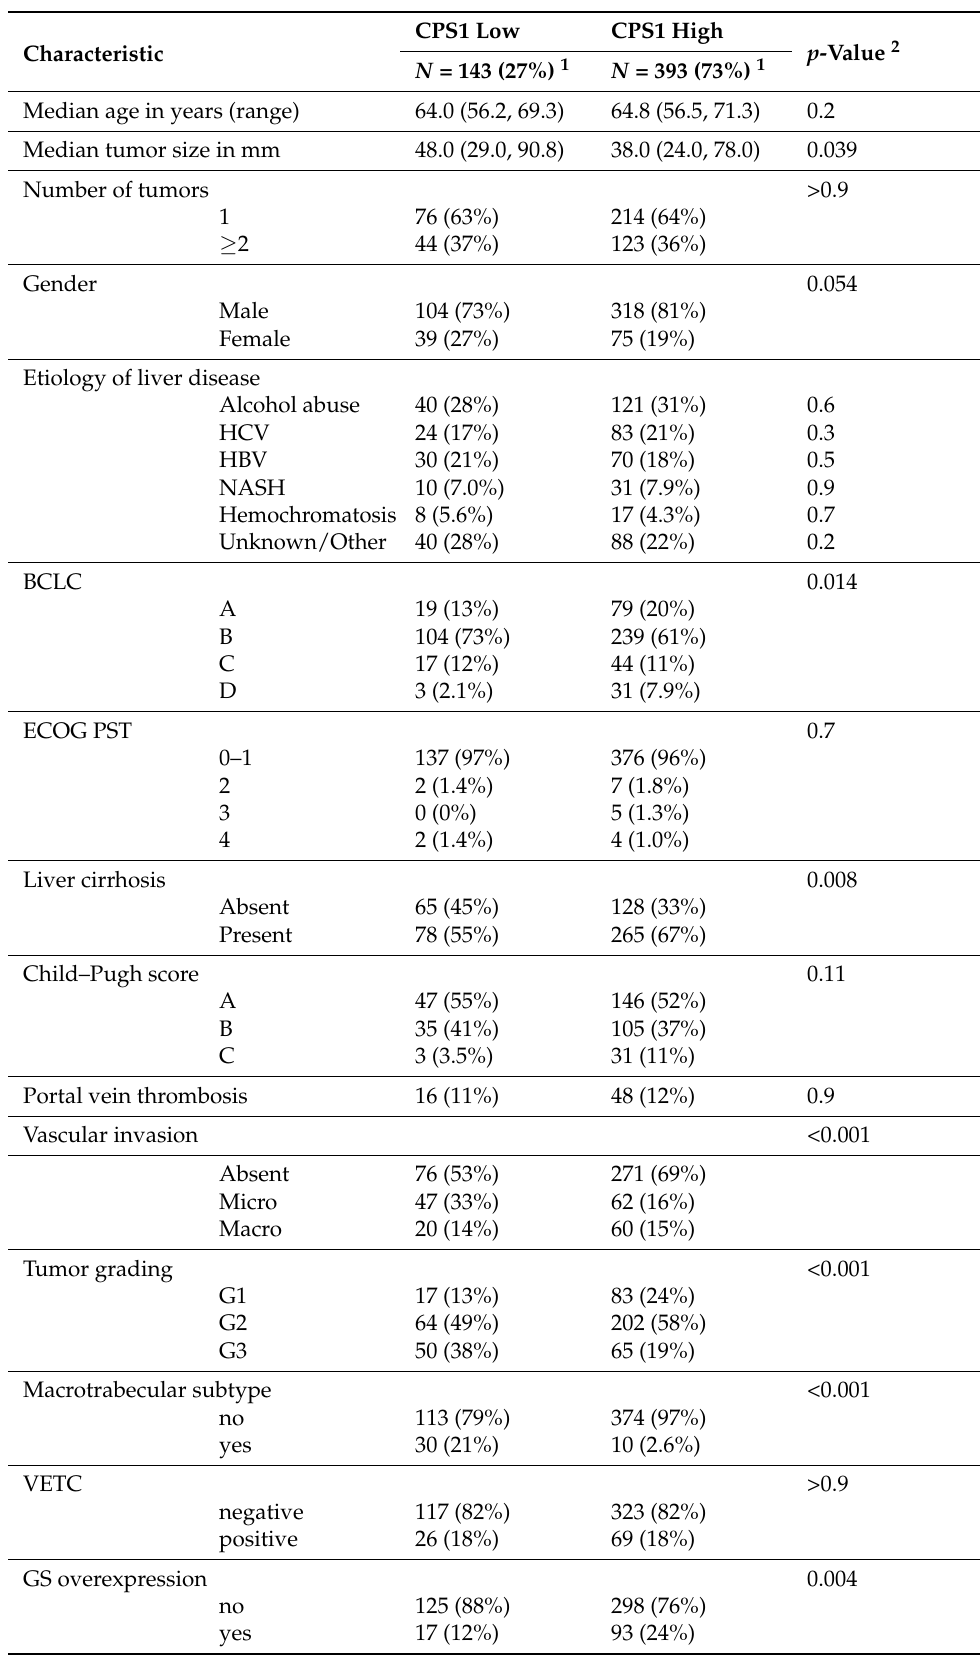
Table 2. Clinicopathologic data associated with high and low immunoreactive scores of